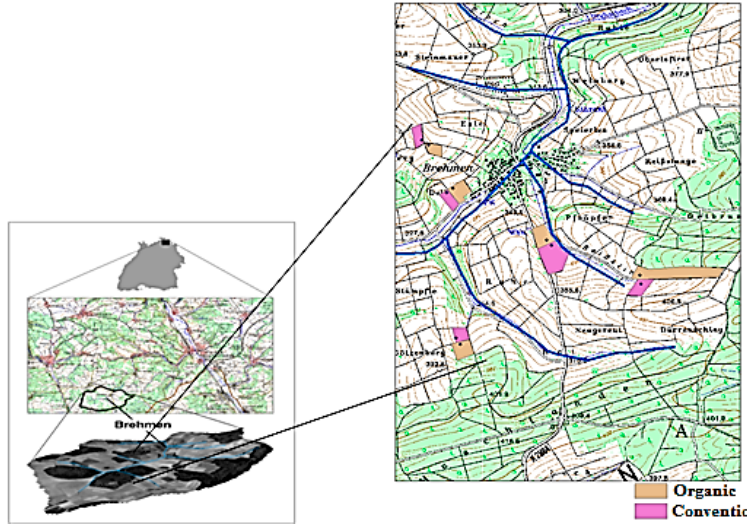
Figure 1. Sample field location of Brehmen village, Tauberbischofsheim, southern Germany.